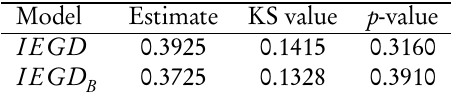
The value of the KS test and